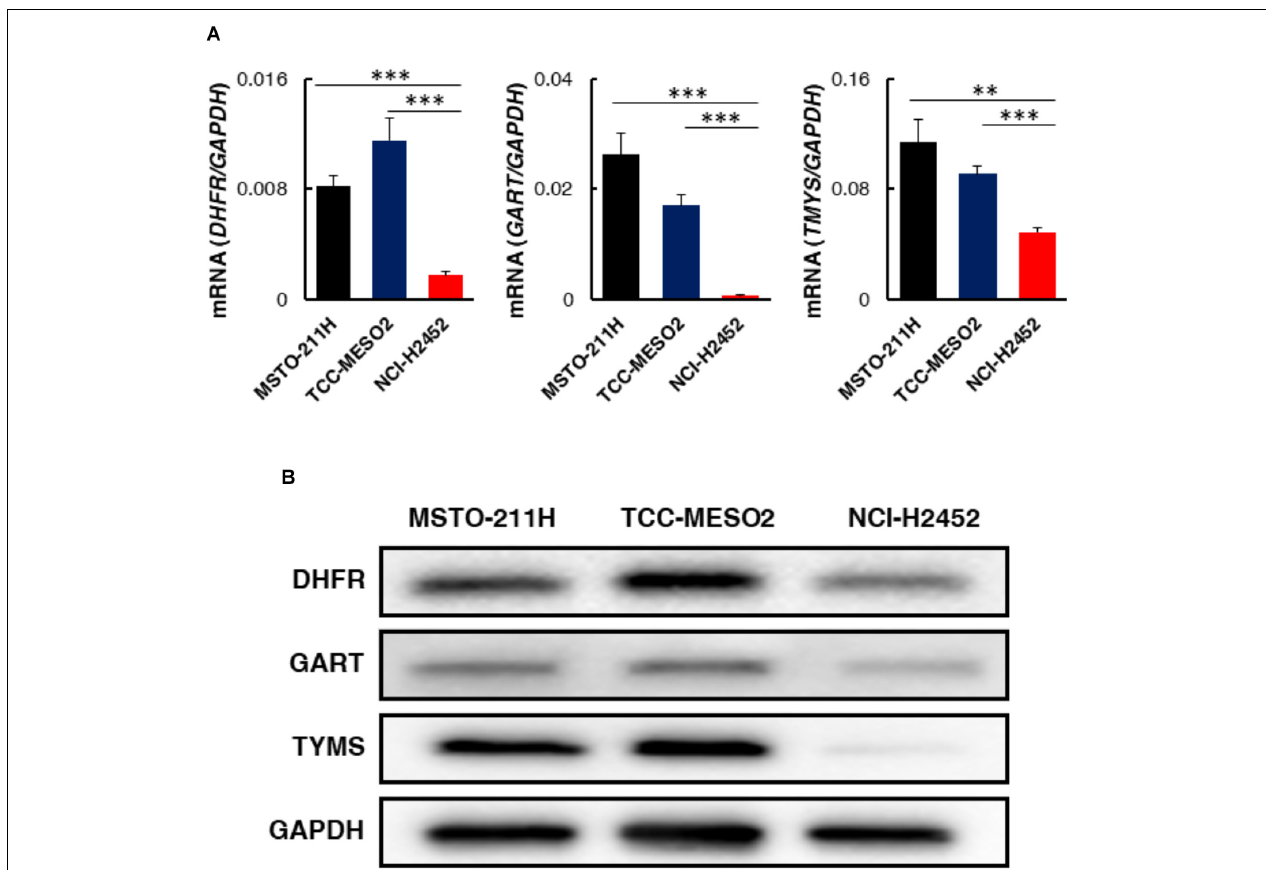
FIGURE 4 | Expression levels of target genes involved in one-carbon metabolism in pemetrexed-sensitive vs. pemetrexed-resistant MPM cells. (A) mRNA expression was evaluated by real-time RT-PCR using the (cid:49)(cid:49) CT method normalized to the housekeeping gene GAPDH. Asterisks show significant difference from NCI-H2452 cells. Error bars indicate s.d. (n = 6). ∗ P < 0.05, ∗∗ P < 0.01, ∗∗∗ P < 0.005 vs. control by two-tailed Student’s t -test. (B) Representative images of Western blotting (WB) characterizing proteins involved in one-carbon metabolism. Equivalent amounts of proteins from whole-cell lysates were subjected to WB analysis to detect the indicated proteins. GAPDH was used as a loading